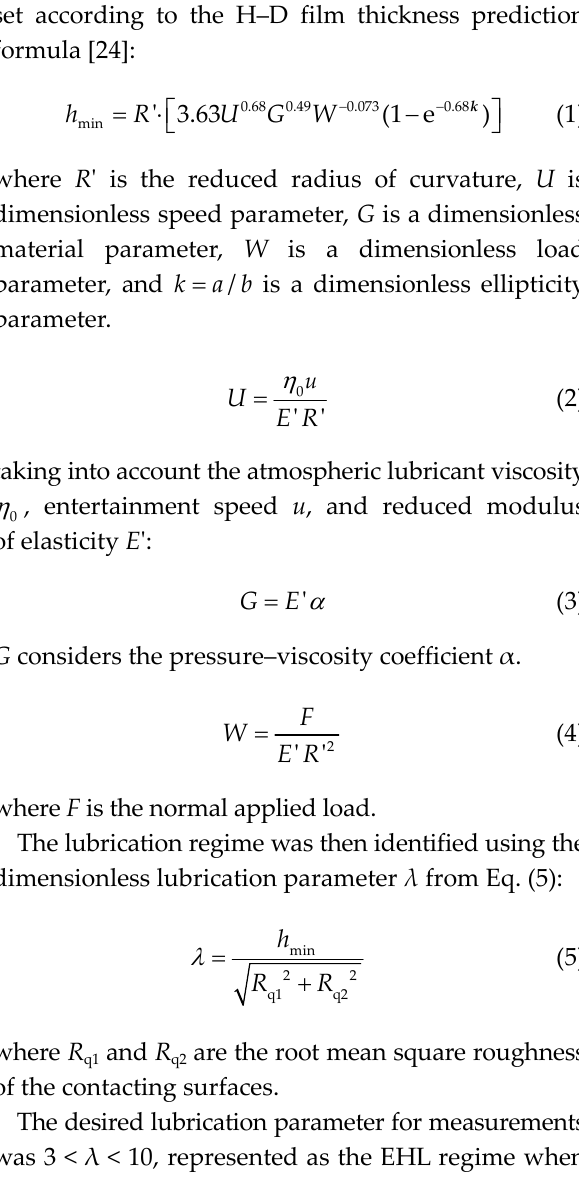
Table 3 MTM contacting tribopair material properties. Property Ball Disc Material Steel (C10) Steel (C45) Dimensions (mm) Ø 12.7 (1/2") Ø 32 Young modulu (GPa) 200 200 Poisson ratio 0.3 0.3 Surface roughness, Ra